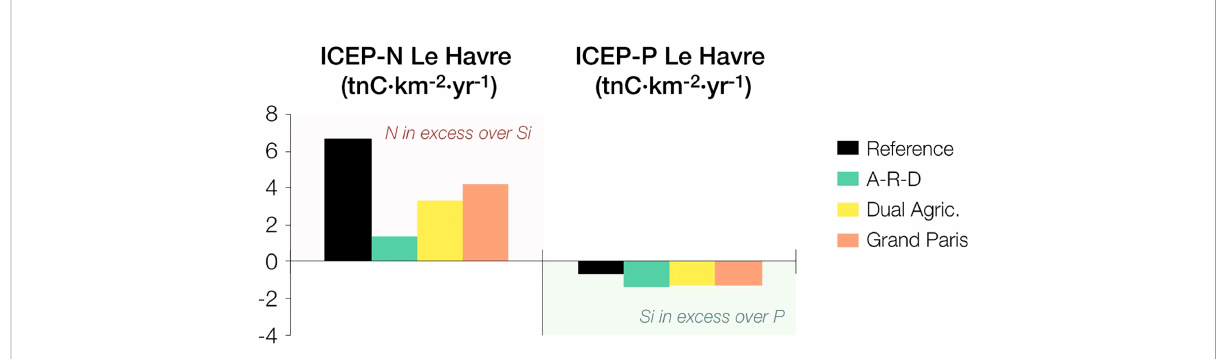
FIGURE 8 Index of Coastal Eutrophication Potential (ICEP) for nitrogen and phosphorus at the outlet of the Seine estuary.